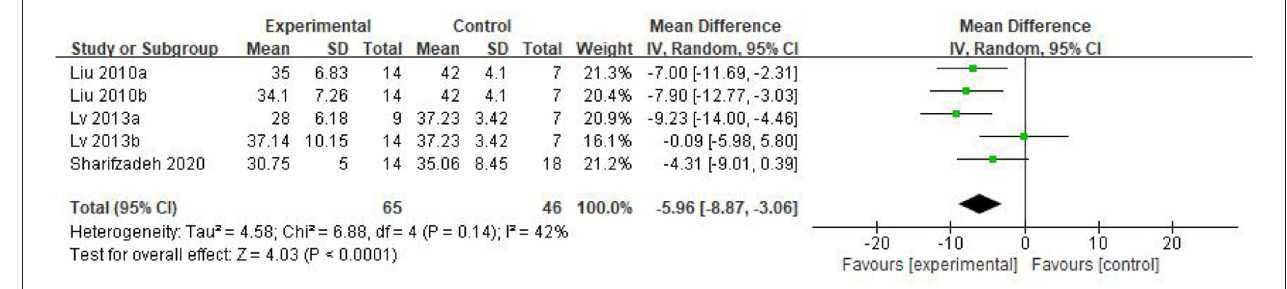
FIGURE 4 | CARS forest plot included in the study.